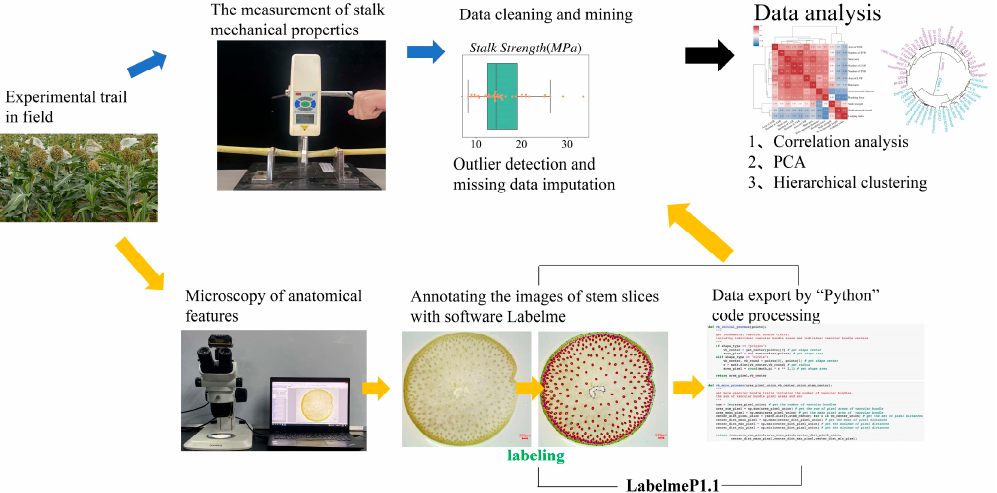
Figure 1. The pipeline for dataset collection, image processing and data analysis.